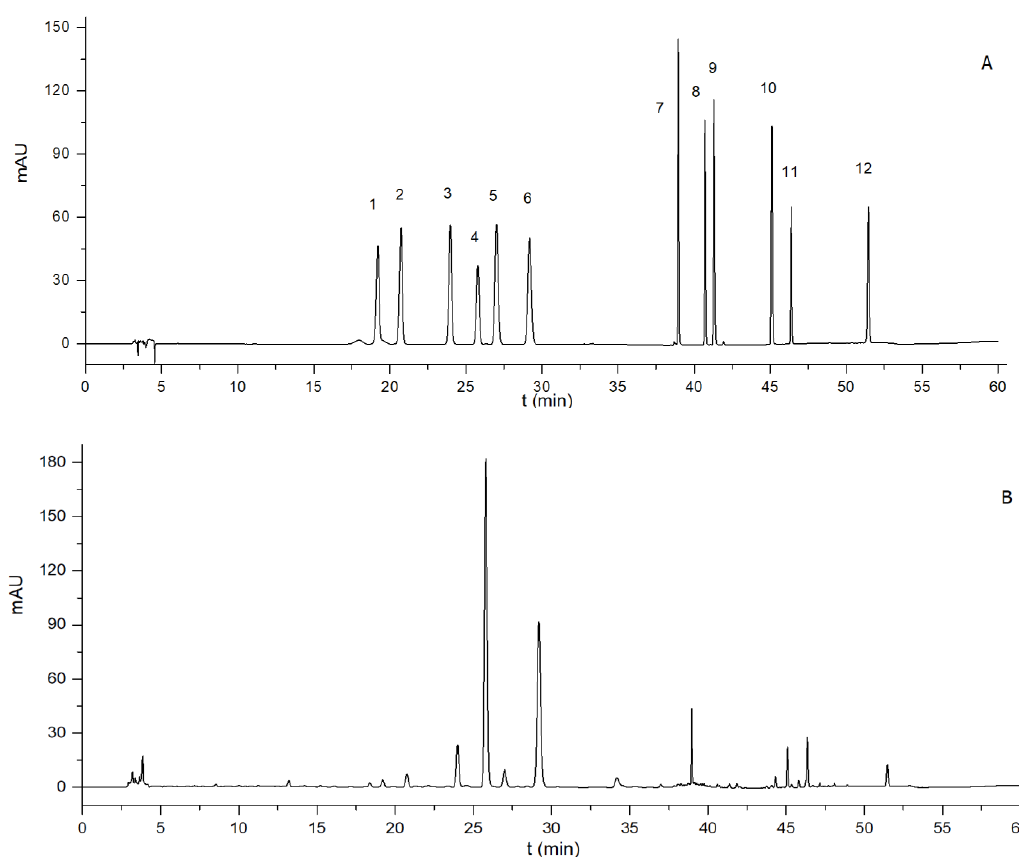
Figure 3. HPLC chromatograms of 12 chemical markers ( A ) and an Aurantii fructus sample ( B ). (1.